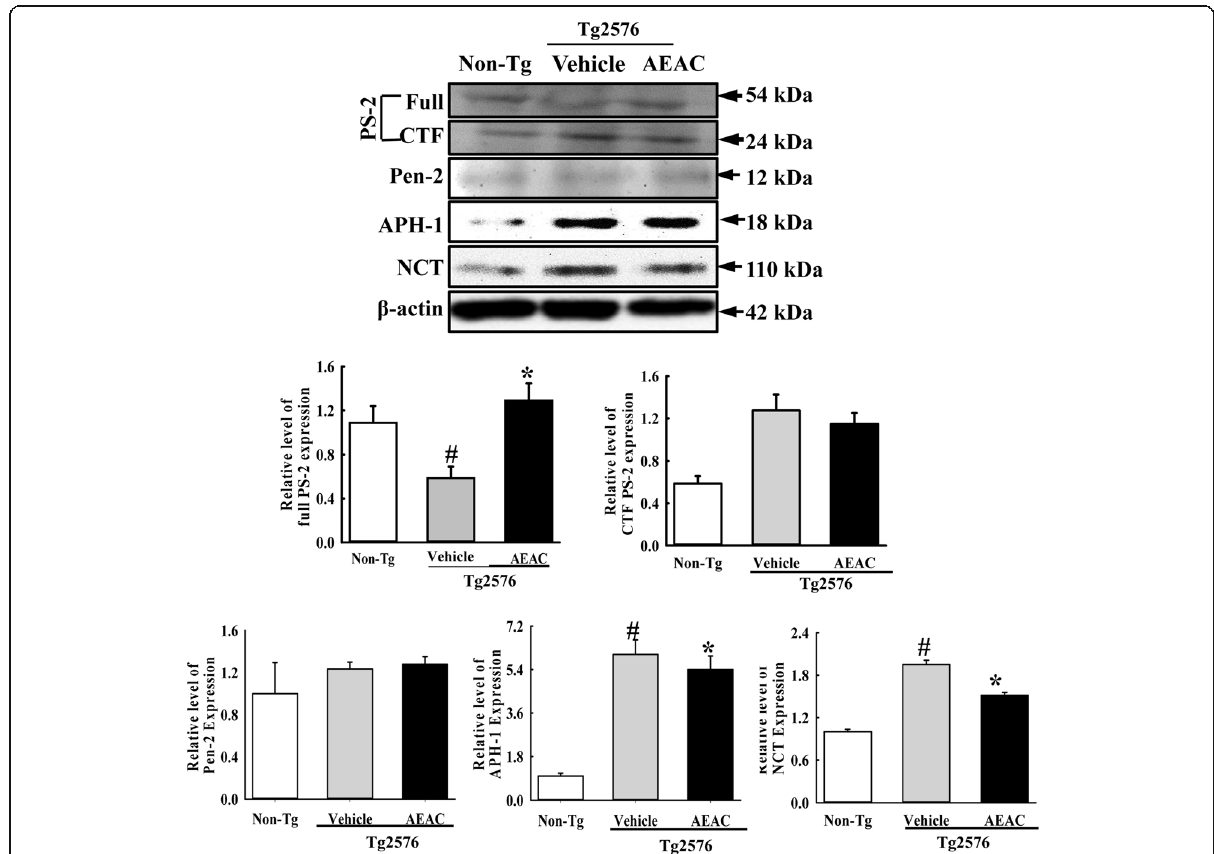
Fig. 7 Expression of γ -secretase components in the brains of Tg2576 mice. Hippocampus regions were prepared from brain tissues of Vehicle and AEAC treated Tg2576 mice. Fifty micrograms of protein per sample was immunoblotted with antibody for each protein. Expression levels of the four γ -secretase components were measured with specific antibody and horseradish peroxidase conjugated goat anti-rabbit IgG, as described in the Methods section. The intensity of each protein was calculated using an imaging densitometer. Data are reported as the means ± SD from three replicates. # , P < 0.05 compared to the Non-Tg group. *, p < 0.05 compared to the Vehicle treated Tg2576